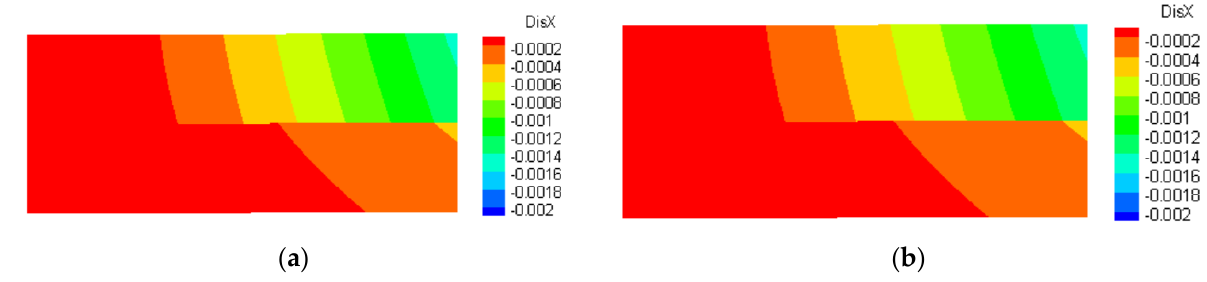
Fractal Fract. 2022 , 6 , 133